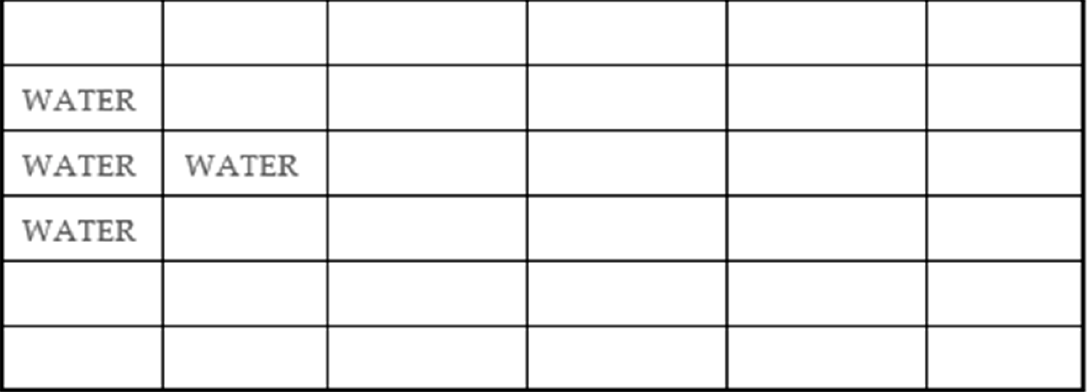
Figure 6. Working Navigation Map WNM’ <x> —what action should occur? (Equation (87)).